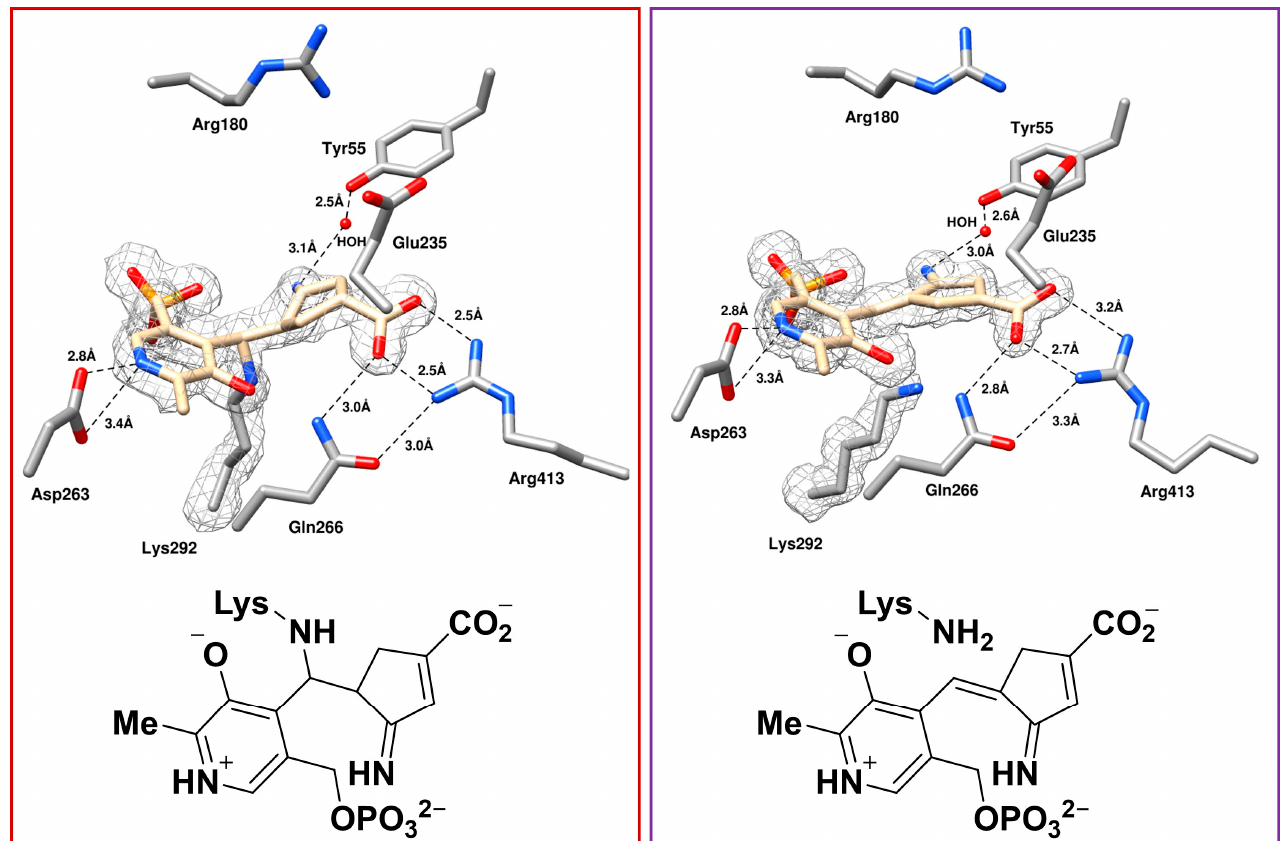
Figure 5. Co-crystal structure of h OAT, inactivated by 5, representing two different ligand forms: covalent ( left ) and noncovalent ( right ) (PDB code: 8EZ1). Both forms were observed within the same co-crystal structure. The covalent form (referred to as minor) was observed in one of three protein copies, while the noncovalent form (referred to as major) was observed in the other two copies. The potential hydrogen bonds are shown as black dashed lines. For both ligand forms, composite omit (2F o -F c ) maps are shown at 1.2 σ . The occupancy factor for the ligand in all copies is equal to 1.0.